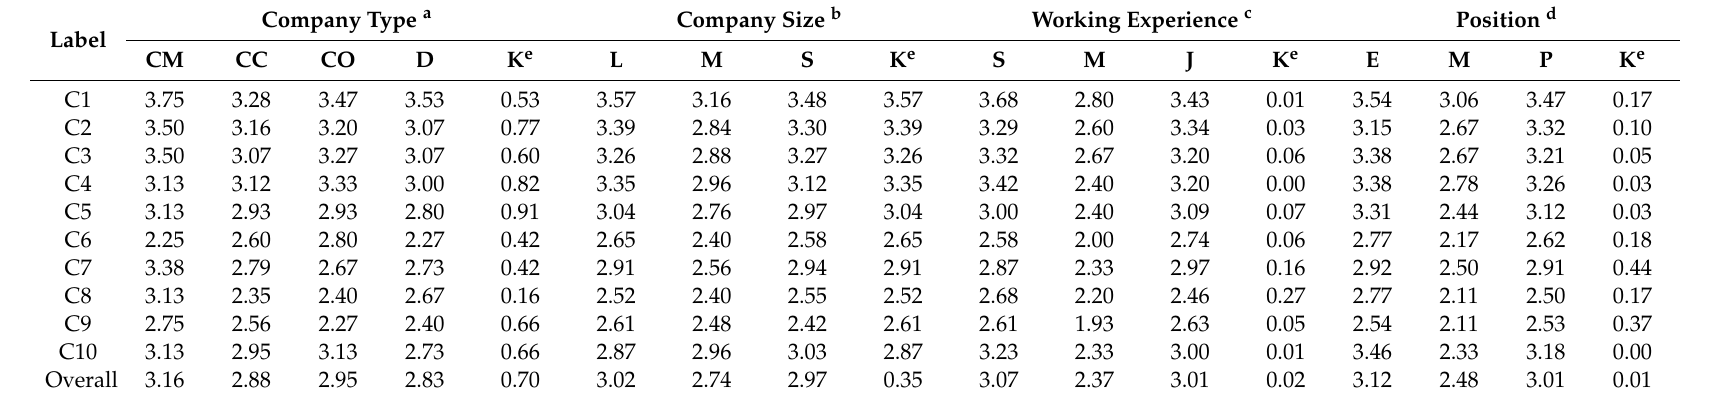
Table 7. Comparison of challenge variables between di ff erent groups of